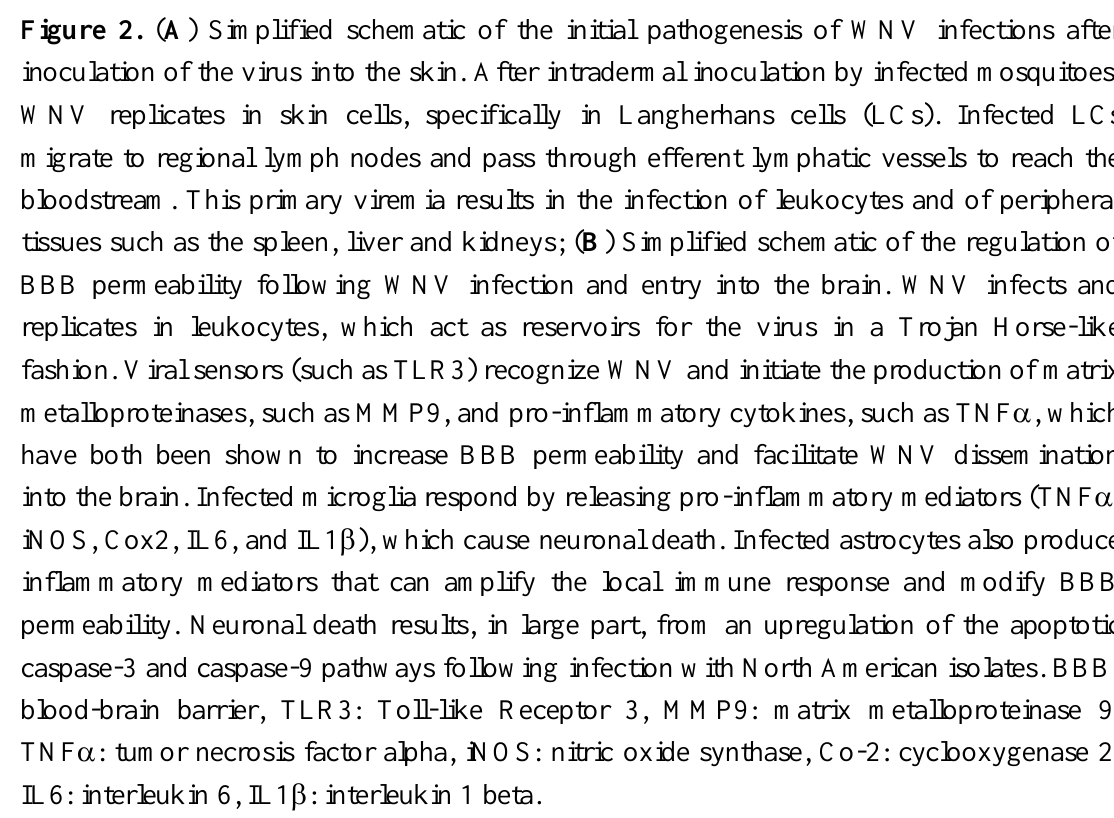
Figure 2. ( A ) Simplified schematic of the initial pathogenesis of WNV infections after inoculation of the virus into the skin. After intradermal inoculation by infected